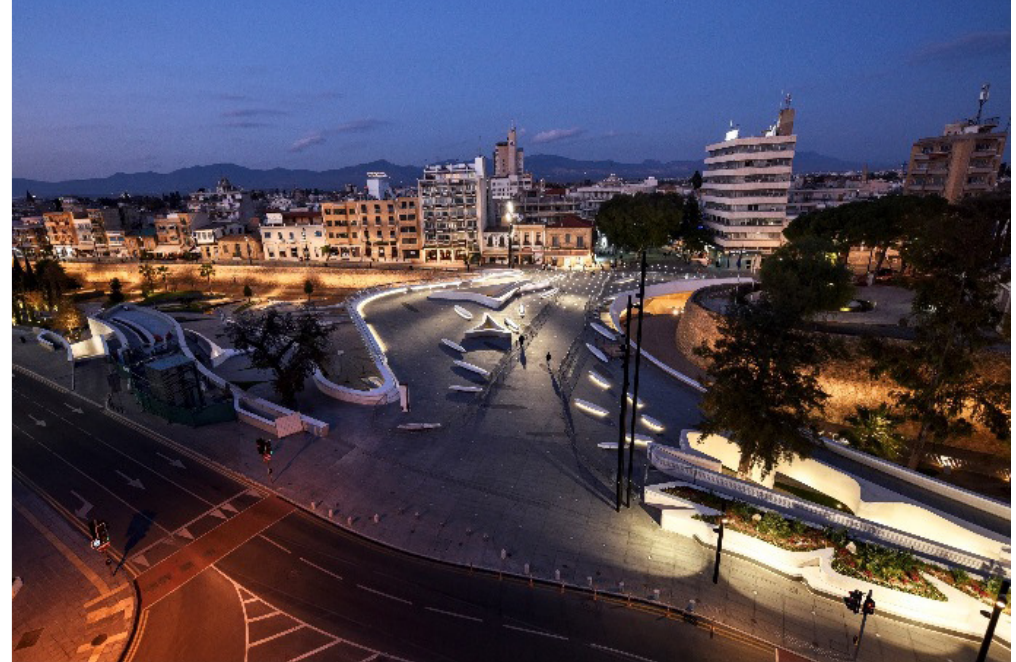
Figure 1. Night view of the implemented Eleftheria Square. Source: Unseen Views